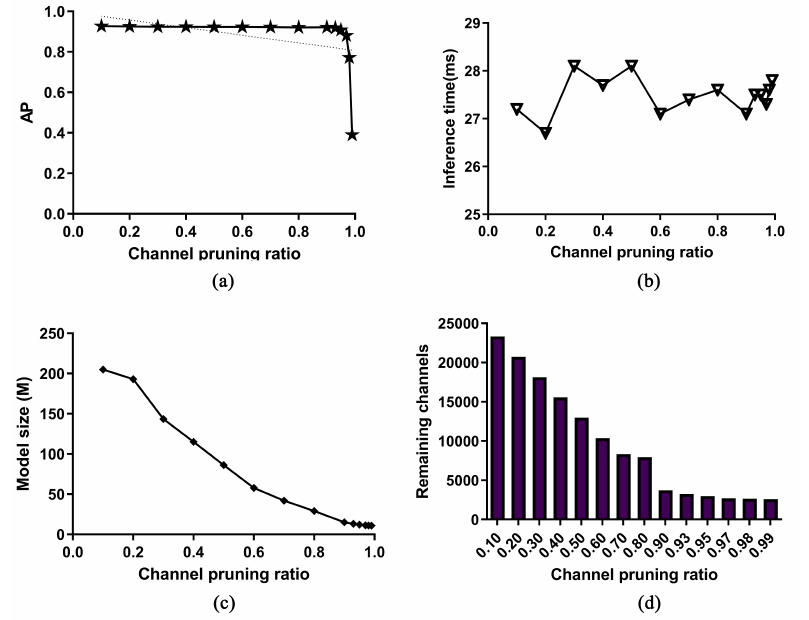
Figure 6. Influence of channel prune ratio: ( a ) AP curve, ( b ) inference time, ( c ) model size and ( d ) the number of